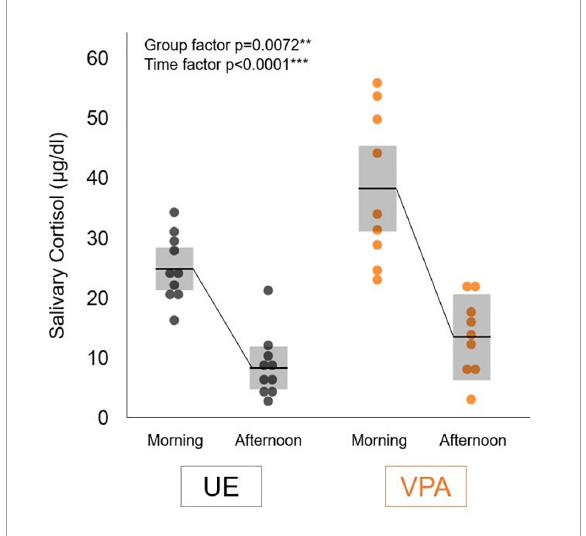
FIGURE1 Salivary cortisol levels in the morning (7:30 a.m.) and afternoon (6:30 p.m.) in the valproic acid-exposed (VPA group) and unexposed (UE group) marmosets. Values are expressed as mean ± standard deviation ( n = 10 for UE group, n = 9 for VPA group, ** p < 0.01, *** p <